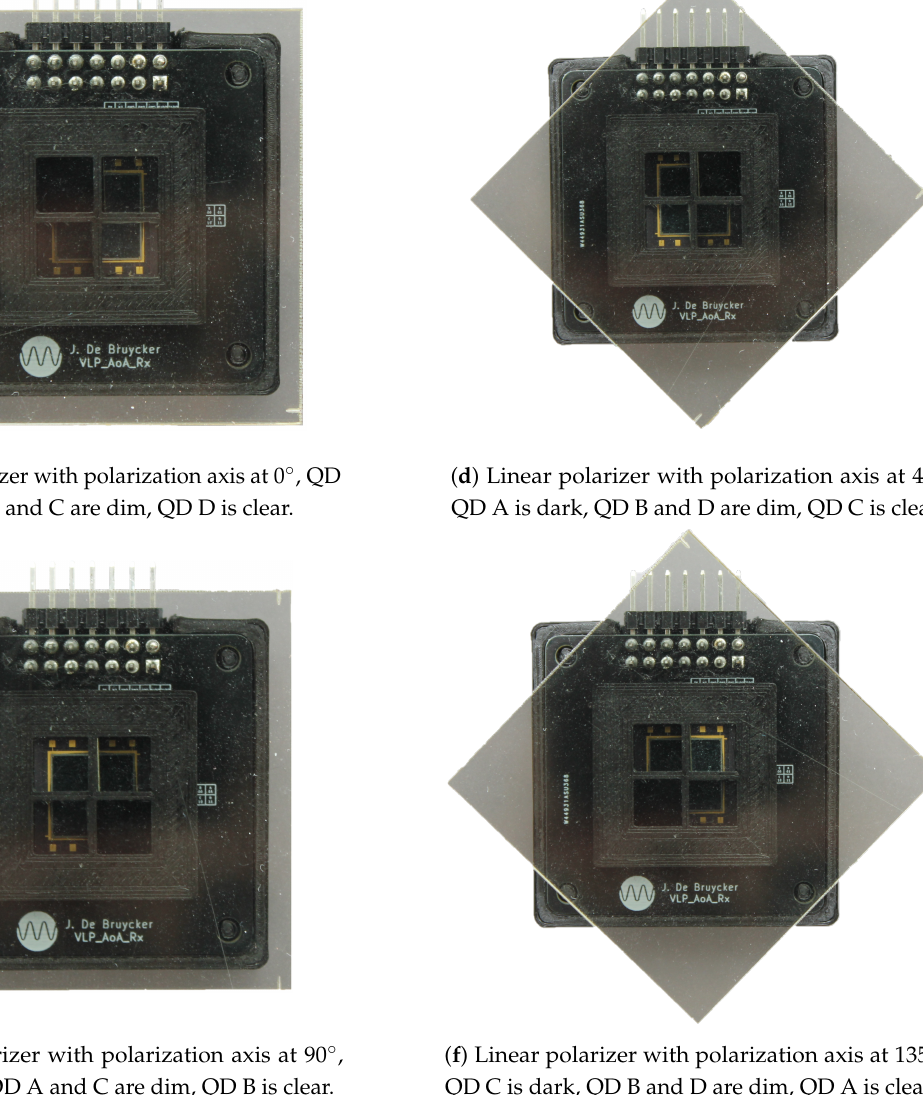
Figure 6. Setup B: four quadrant receiver with aperture containing four linear polarizers subsequently rotated over 45 ◦ , note the orientation of the linear polarizing film at each